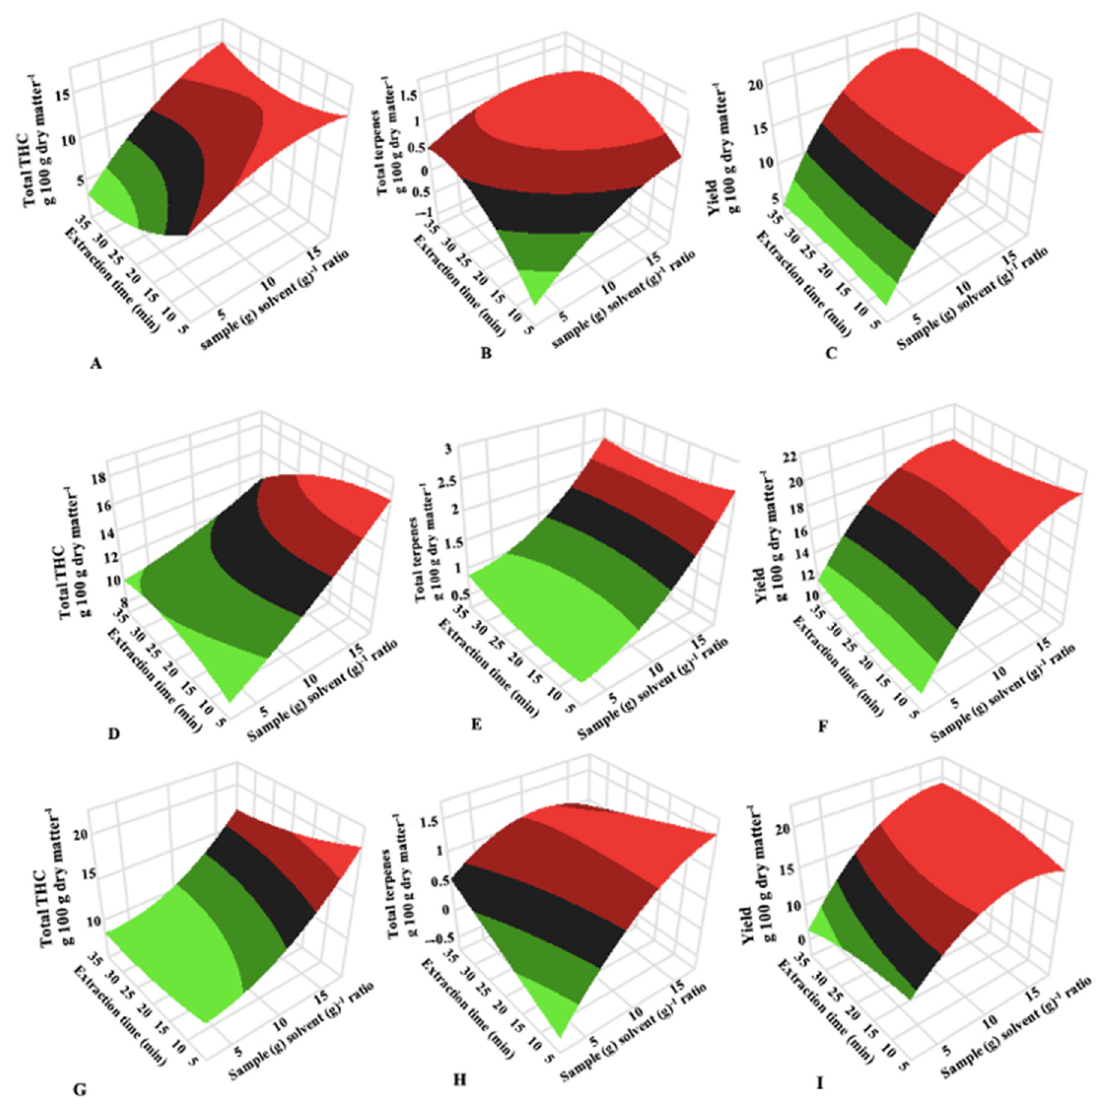
Figure 1. 3D plots showing the combined effects of sample (g) ‐ to ‐ solvent (g) ratio and extraction time (min) on the concentration (g 100 g dry matter − 1 ) of total THC ( A , D , G ), total terpenes ( B , E , H ), extraction yield ( C , F , I ) for cold ethanol extraction of cannabis at − 20 °C ( A – C ), − 40 °C ( D , E ), and room temperature ( G – H ).